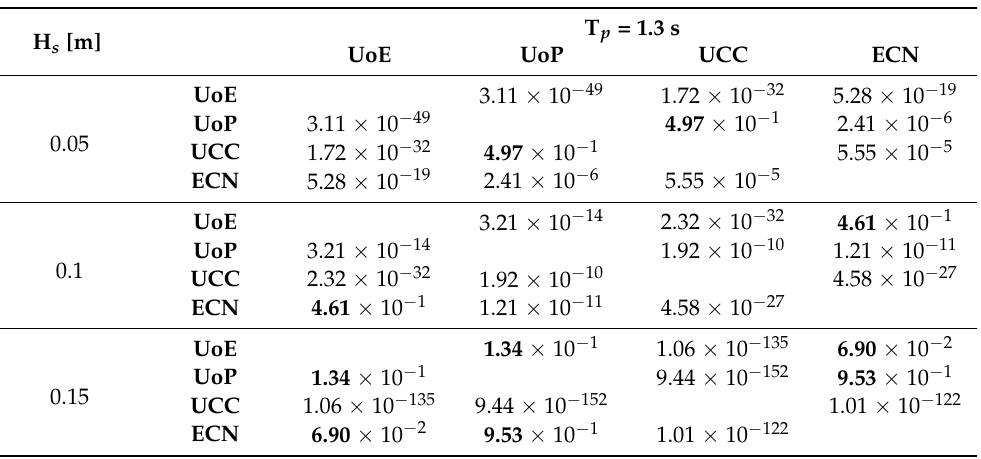
Table A3. Mann–Whitney U test p -values, T p = 1.55 s. Values greater than 0.05 marked in bold. H s [m]